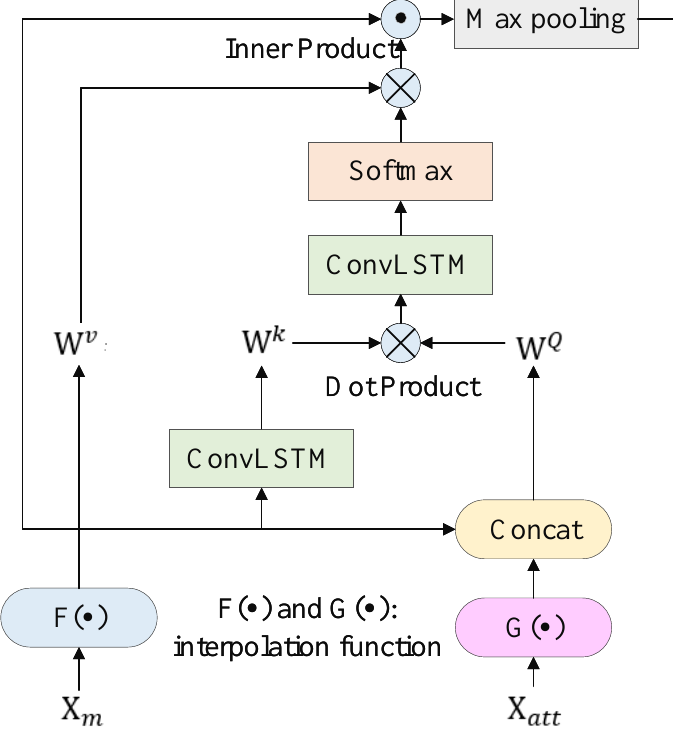
Figure 3. Spatial–temporal cross-attention